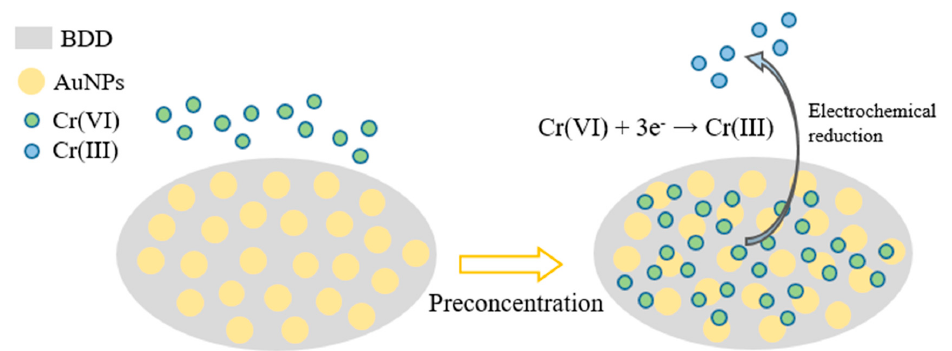
Figure 1. Working principle of Cr (VI) detection by gold nanoparticles (AuNPs)–boron-doped diamond (BDD)